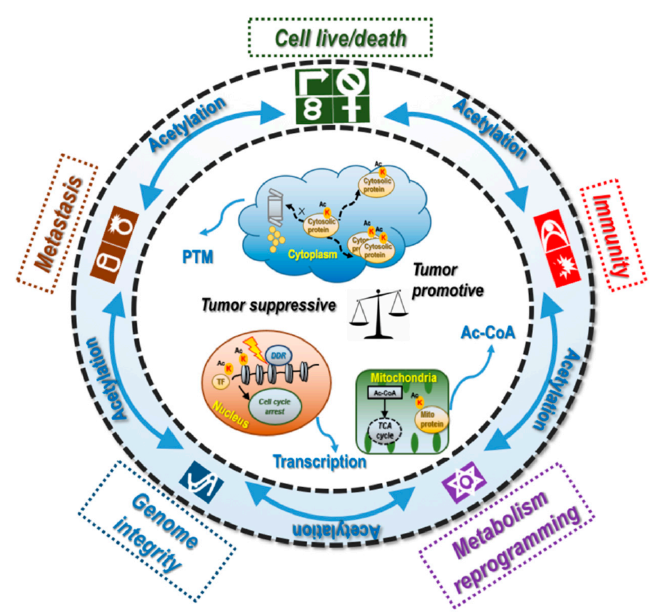
Figure 3. Crosstalk of cancer hallmarks as mediated via lysine acetylation. Cancer hallmarks develop crosstalk among themselves given the existence of some intrinsic connections such as the involvement of DDR in both cancer cell life/death control and genome integrity. Lysine acetylation plays critical roles in these dialogues as it can modulate the levels and functionalities of tumor suppressors and oncogenes involved in this cancer hallmark signaling at the transcriptional (nucleus), PTM (cytoplasm), and metabolic (mitochondria)